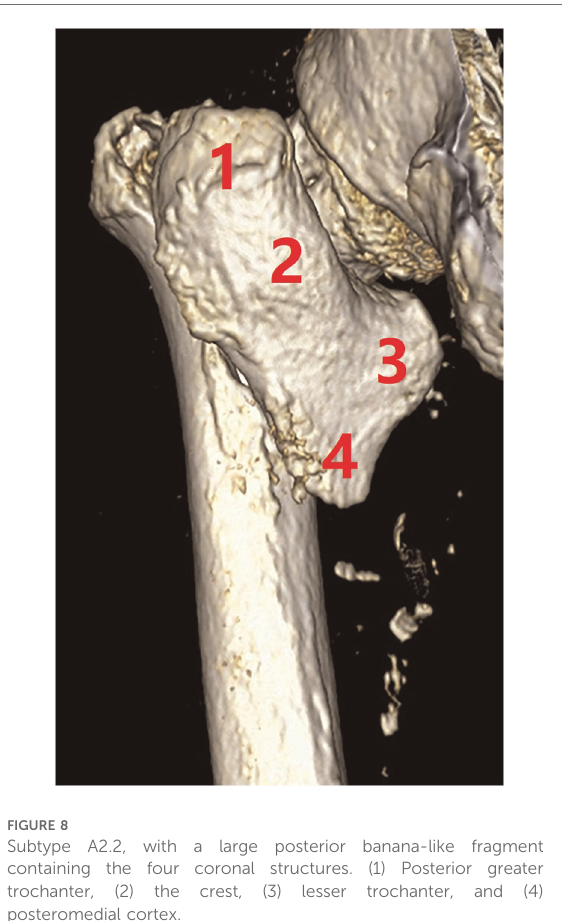
FIGURE 8 Subtype A2.2, with a large posterior banana-like fragment containing the four coronal structures. (1) Posterior greater trochanter, (2) the crest, (3) lesser trochanter, and (4) posteromedial